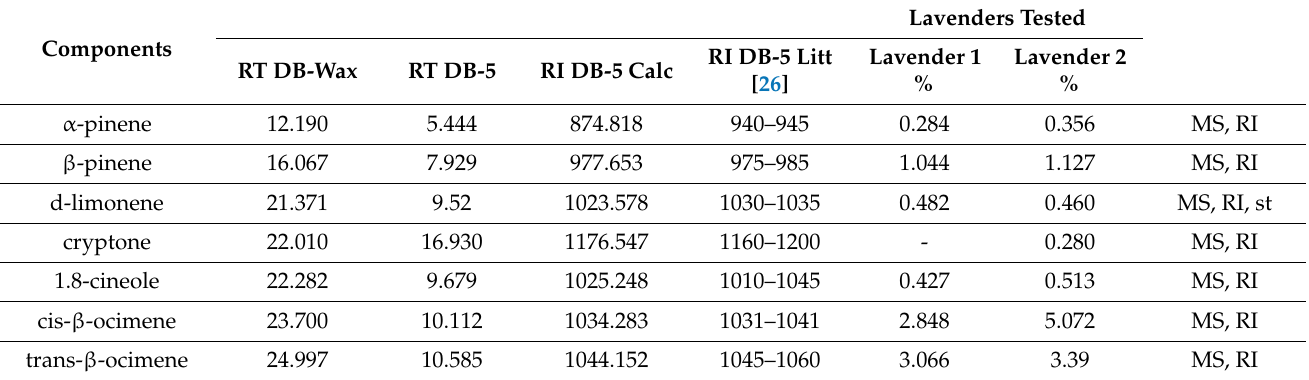
Table 1. Composition and pollutants analysis of lavender essential oils (EOs) (mass